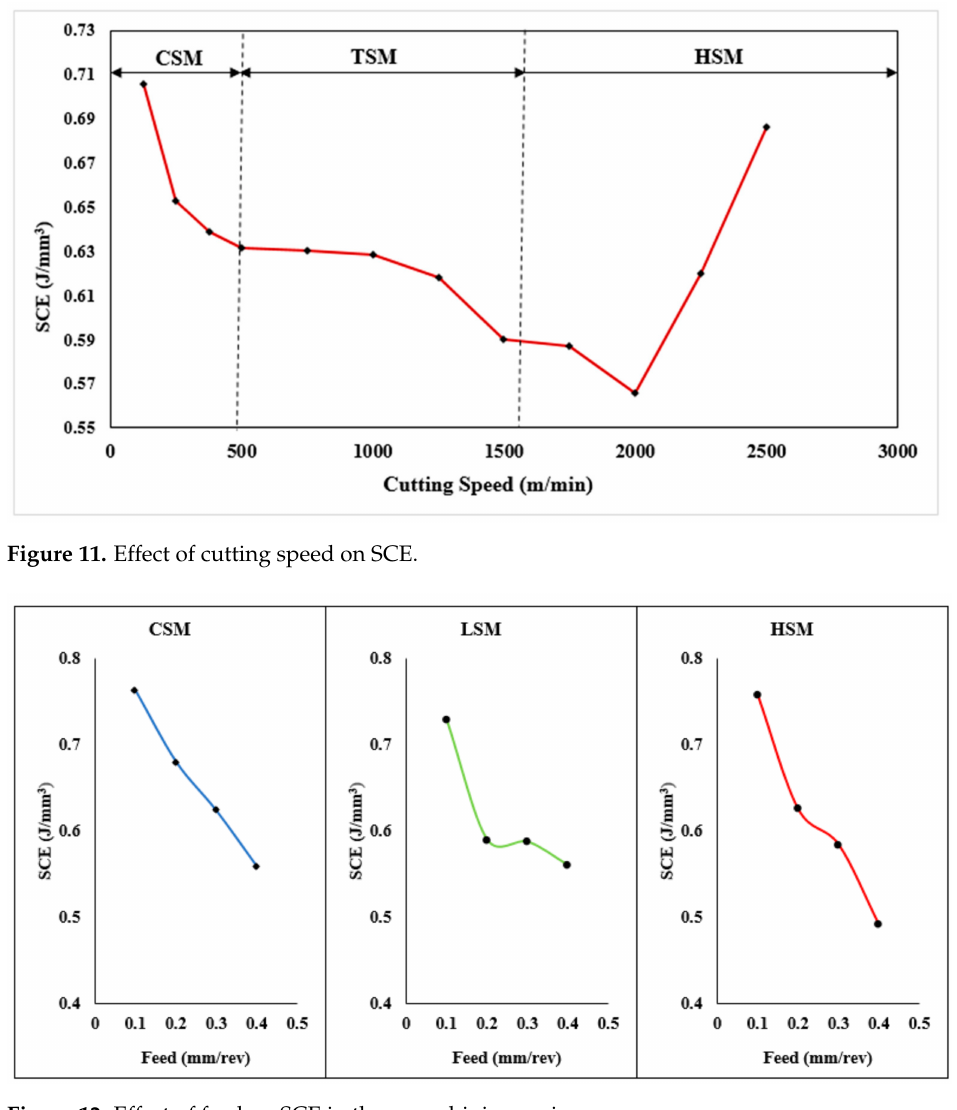
Figure 12. Effect of feed on SCE in three machining